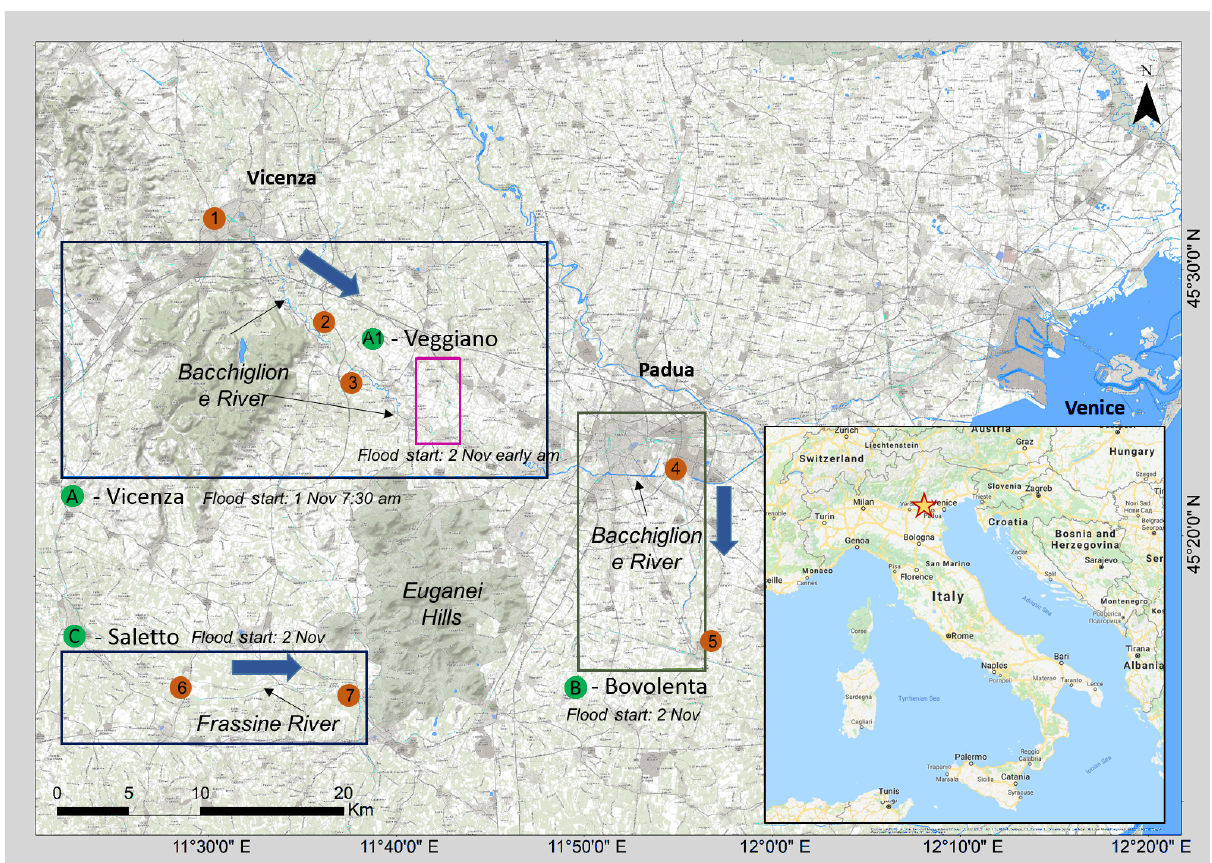
Figure 3. Overview of the area affected by the 2010 flood event that occurred in the Veneto region (Italy). The three main areas of interest are highlighted by the three frames: (A) Vicenza, (B) Bovolenta, and (C) Saletto. Placeholder A1 refers to the Veggiano area covered by the hydrodynamic modeling used for comparison purposes. The numbers in orange circles indicate the location of the hydrometers, whose measurements are reported in Fig. 4. For each frame the flood start date is reported along with the direction of the flood wave (blue